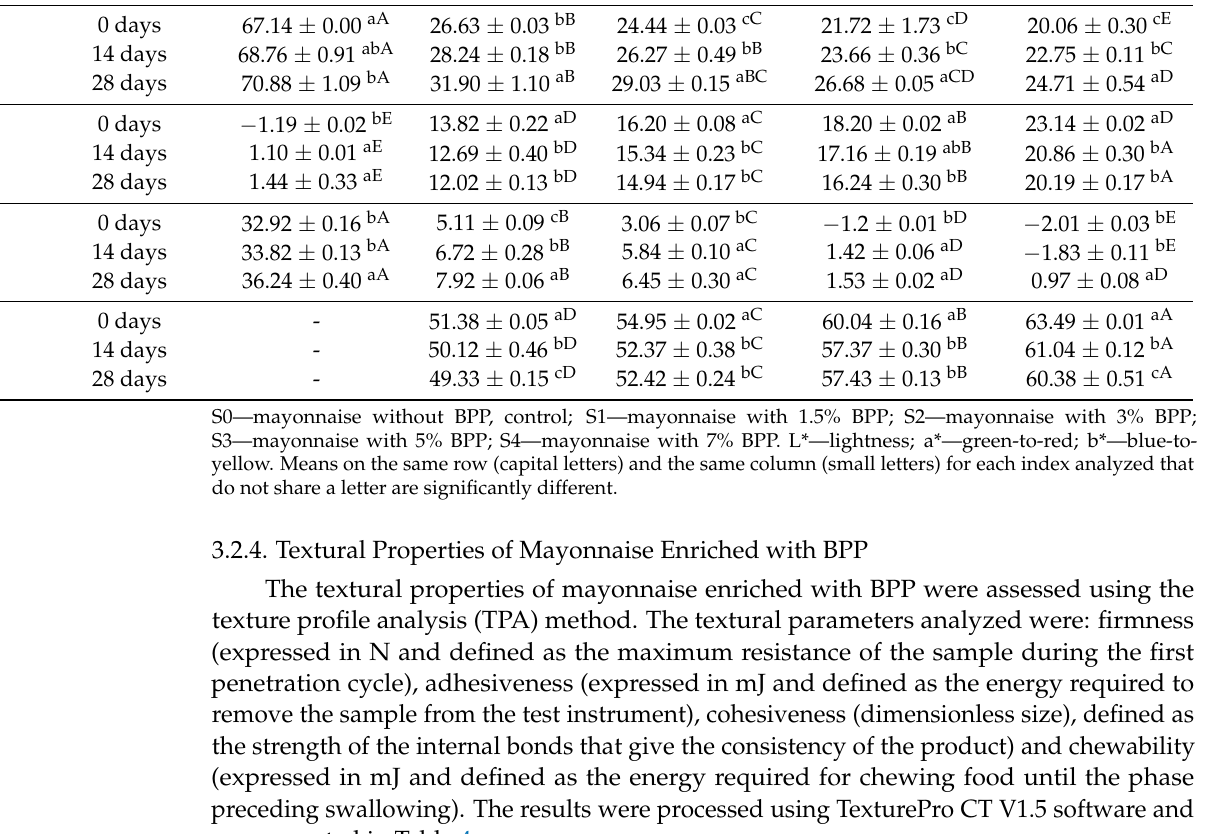
CIELAB Color Parameters